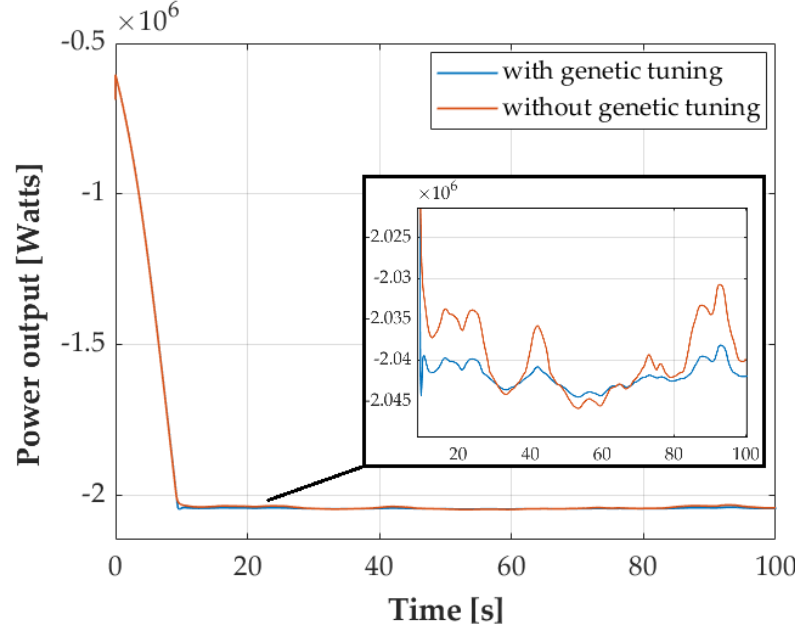
Figure 10. Power output with (blue line) and without (red line) using genetic algorithm.